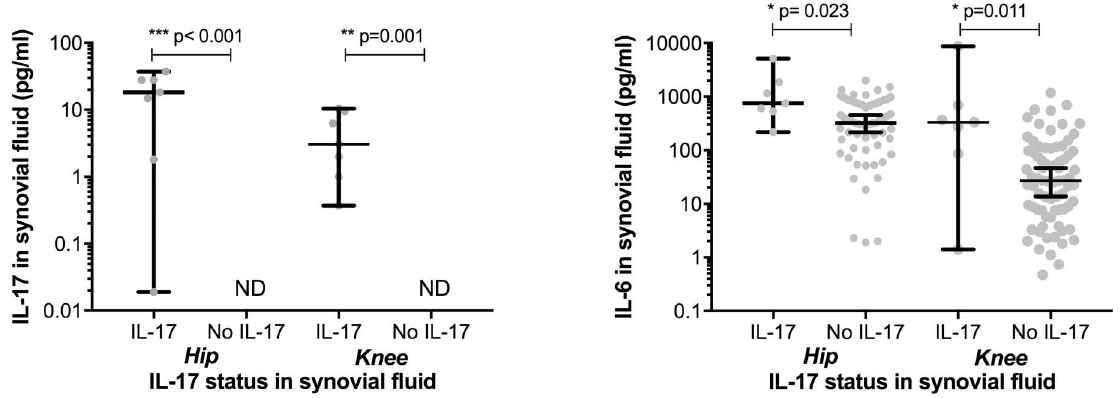
Fig 2. Synovial fluid concentrations of IL-17 and IL-6 in patients following stratification by hip or knee OA. Error bars show median ± 95% confidenceintervals, * p < 0.05, ** p < 0.01, ** p < 0.001,ND = not detectable.